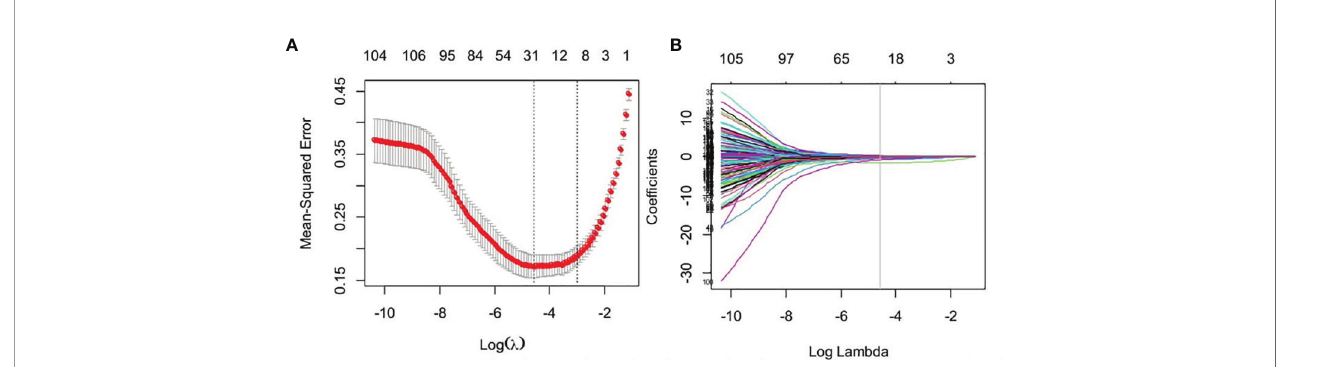
FIGURE 2 | Feature selection using the least absolute shrinkage and selection operator (LASSO) binary logistic regression model. (A) Tuning parameter (lambda) selection in the LASSO model used 10-fold cross-validation via minimum criteria. (B) The gray line in the fi gure is the partial likelihood estimate corresponding to the optimal value of lambda. The optimal lambda value of 0.061 was